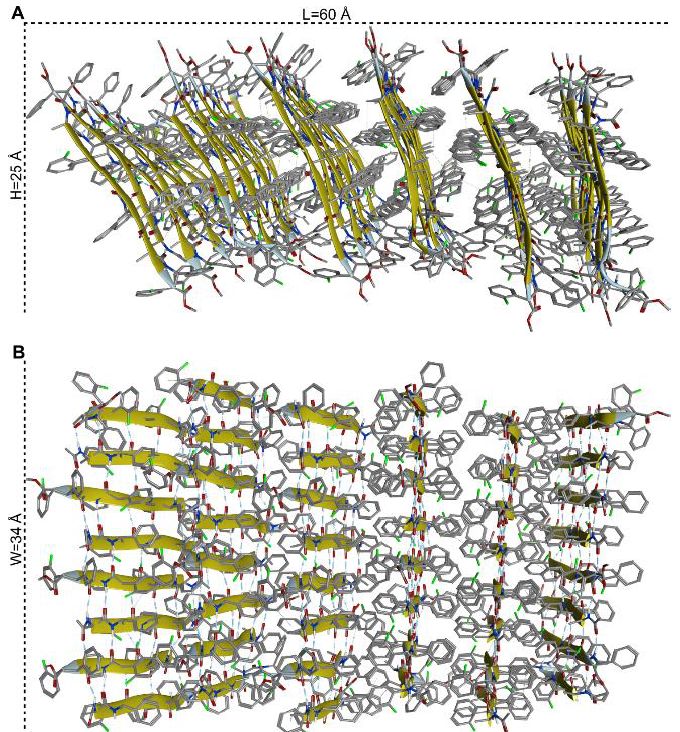
Figure 8. Side ( A ) and top ( B ) views of the 6 × 8 assembly of model peptide 1 . The geometry corresponds to the representative structure of the most populated cluster (population = 85%) obtained by cluster analysis of the last 400 ns of the 1 μs MD trajectory in explicit solvent. L is the average distance between the C-terminus of corresponding peptides in the first and the last β-sheet; W is the average distance between the C=O groups at the C- and N-terminal protections of the first and the last peptide within each β-sheet, while H corresponds to the average length of each peptide, as measured between the C=O groups.